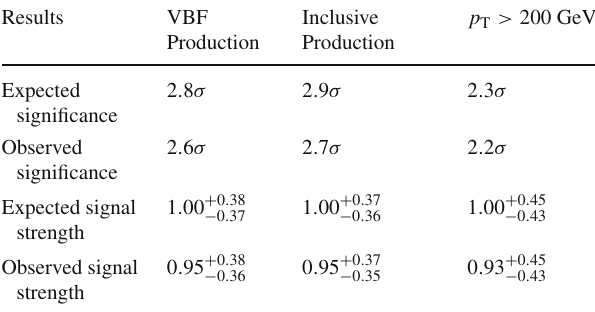
Fig. 6 The m bb distribution after subtraction of non-resonant back- ground, with signal regions 1 through 4 for both channels weighted by ln ( 1 + s / b ) within the range 112 < m bb < 136 GeV and summed. This range corresponds to roughly 68% of the total Higgs boson signal template width. The value of s is calculated from the observed Higgs boson signal (including all H → b ¯ b production processes) within this range for each region, and b is calculated from the post-fit background yields in each region. The data are the black points, the Z contribution is in grey, the fitted VBF Higgs boson signal is in red, and maroon are events attributed to the other Higgs boson production mechanisms (ggF + t ¯ tH + V H ). The hashed band shows the fitted background uncertain- ties Table 4 Expected and observed significances and signal strengths for Higgs boson production, for VBF production, inclusive production, and production with a Higgs boson true p T of greater than 200 GeV, relative to the Standard Model prediction